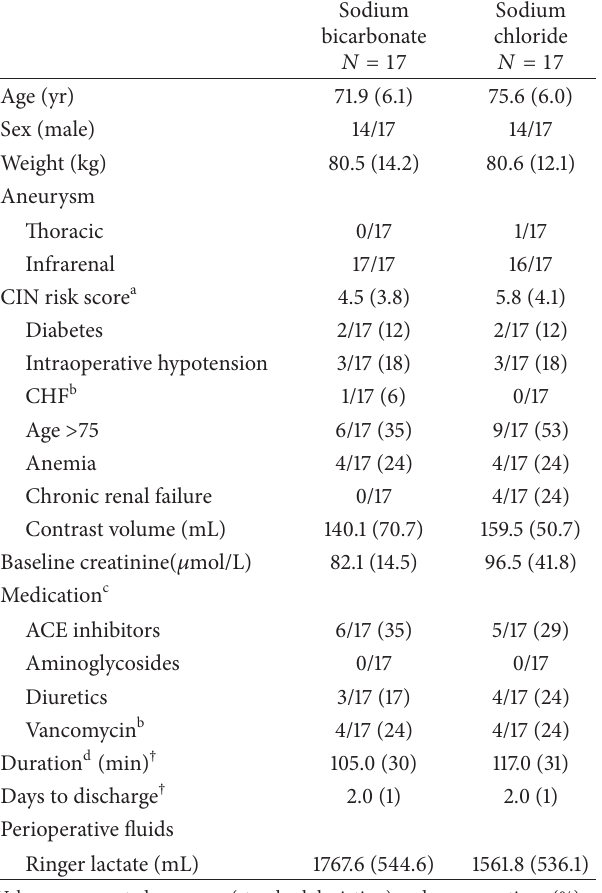
Table 1: Demographic subject characteristics. Table 2: Baseline values for creatinine, cystatin C, serum, and urinary NGAL, IL-18, NAG, and KIM-1 according to study